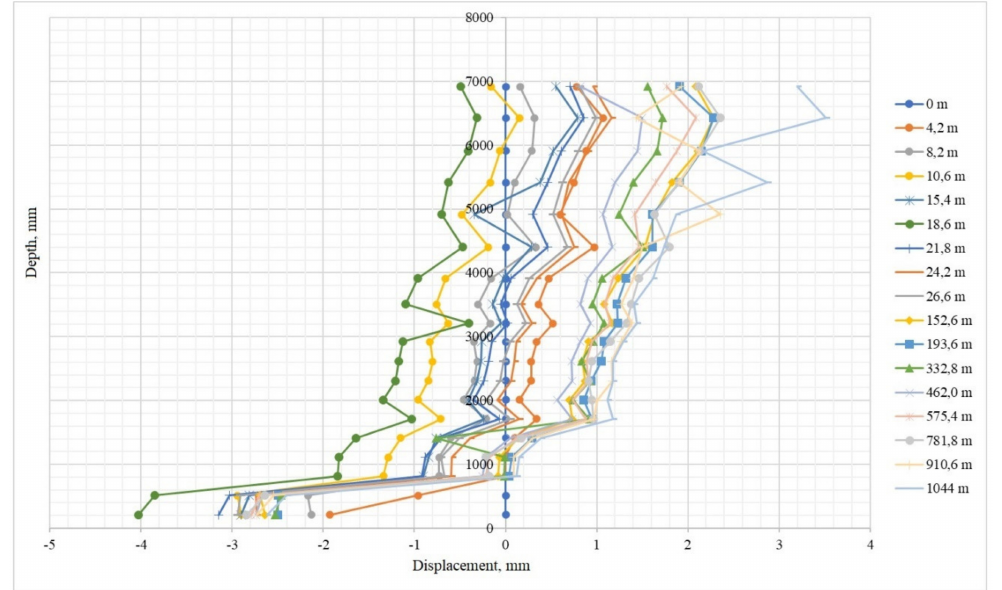
Figure 11. Roof displacements measured using extensometric probe–periodic control station no.